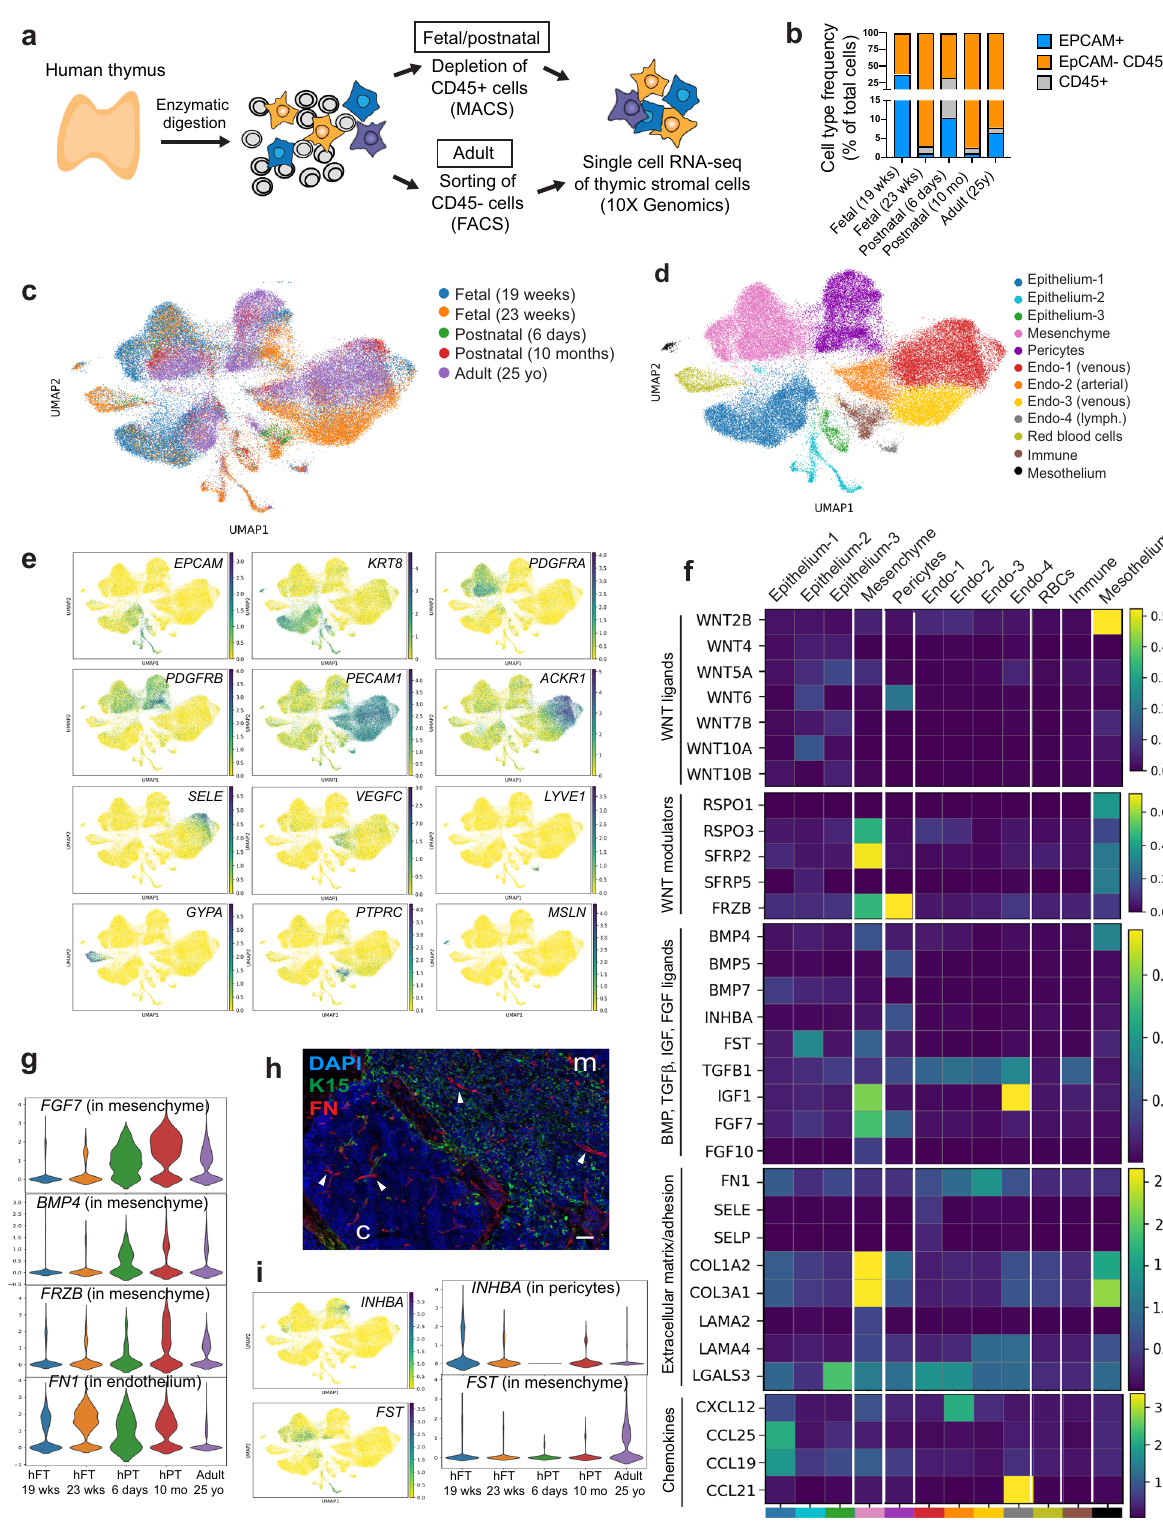
Pro fi ling of human TECs at different stages . To further de fi ne heterogeneity within the epithelial compartment, the three epi- thelial superclusters (Fig. 1d, Epithelium-1, -2, and -3) were divided into nine distinct sub-clusters (Fig. 2a, b). The clusters were annotated based on a combination of known TEC markers and a list of differentially expressed genes (Fig. 2c, d and Sup- plementary Data 2). Two clusters expressed genes